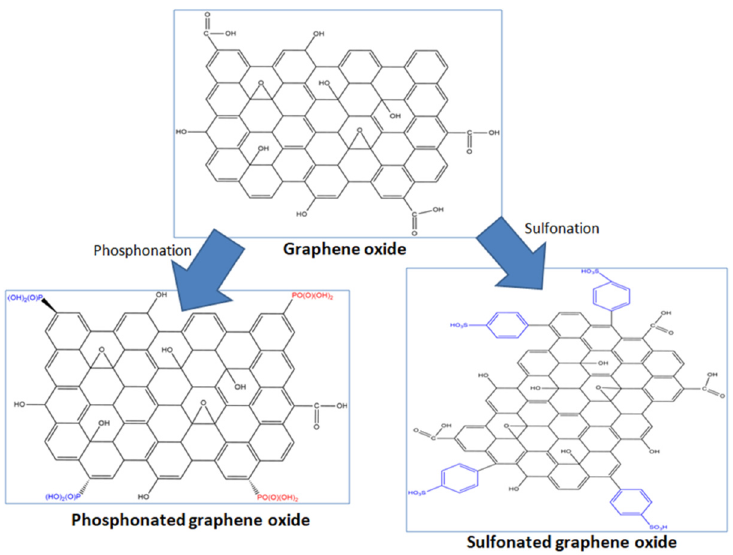
Figure 1. Schematic diagram of graphene oxide and its sulfonated and phosphonated forms.